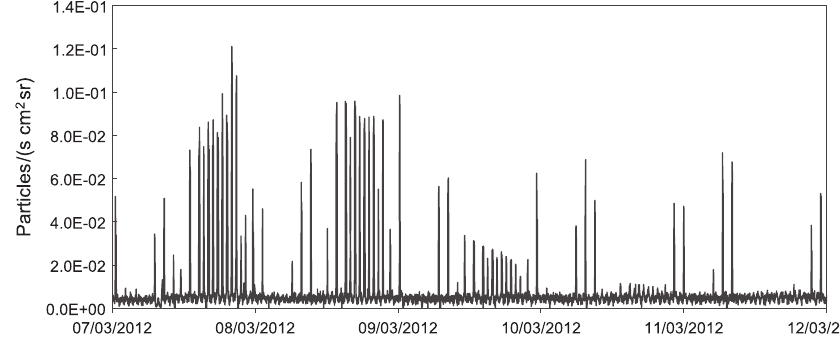
Fig. 6. Particle flux integrated over one minute: the flux enhancement between March 7th and 9th is the signature of a solar event.